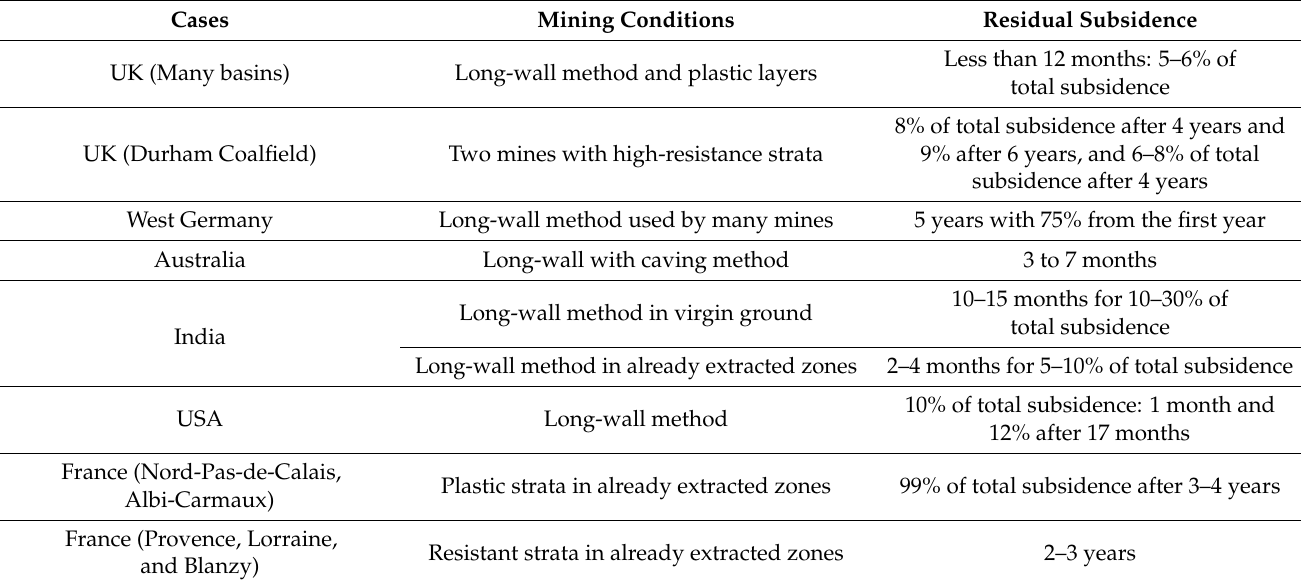
Table 1. Duration and amplitude of residual subsidence phase